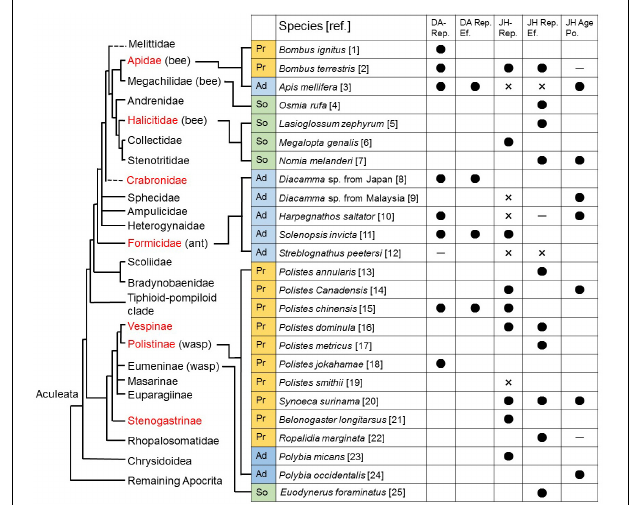
FIGURE 1 | Roles of dopamine and juvenile hormone in reproductive females in Hymenoptera. A phylogenetic tree based on Gullan and Cranston (2014) is modified. Possible non-monophyletic families are shown in quotes on a dashed branch. Families containing eusocial species are indicated in red. In this figure, evidence of correlation and causal relationships are extensively evaluated. Correlation between dopamine levels in the brains and reproduction (DA-Rep.), and between juvenile hormone titers in hemolymph and reproduction (JH-Rep.) are indicated as positive ( • ), negative ( × ), and neutral (–). Effects of dopamine (DA Rep. Ef.) and juvenile hormone (JH Rep. Ef.) on reproduction, the relation of juvenile hormone with age polyphenism (JH Age Po.) are also indicated. Ad: advanced eusocial, Pr: primitively eusocial, So: solitary and facultatively eusocial (Bohm, 1972; Bell, 1973; Barth et al., 1975; Röseler, 1977; Robinson et al., 1992; O’Donnell and Jeanne, 1993; Sommer et al., 1993; Harris and Woodring, 1995; Robinson and Vargo, 1997; Bloch et al., 2000; Pinto et al., 2000; Boulay et al., 2001; Sasaki and Harada, 2020; Agrahari and Gadagkar, 2003; Brent and Vargo,